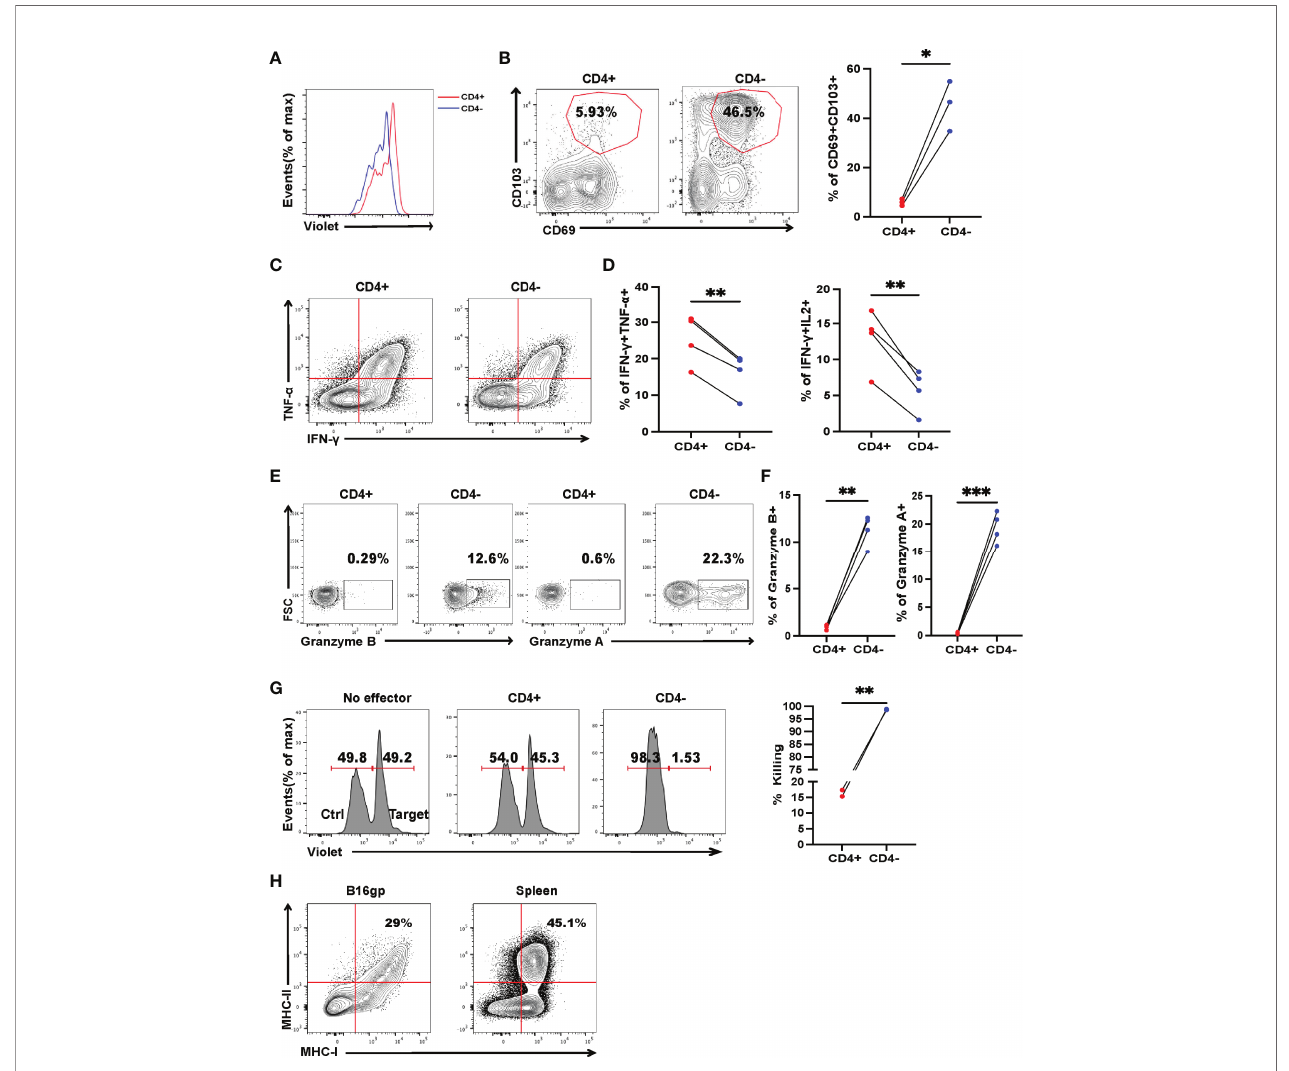
FIGURE 3 | Cytotoxic CD4 – T cells, differentiated from CD4 + T cells, are critical for controlling established tumor metastasis. Tumor-bearing mice were treated with 2 × 10 6 activated SMARTA cells eight days after tumor inoculation and sacri fi ced on Day 7 or Day 15 post-transfer. (A) Flow cytometry analysis of the dilution pattern of the cell proliferation dye on CD4 + and CD4 – SMARTA cells which were sorted from the metastatic lung tissue on Day 7 post cell transfer and labeled with CellTrace Violet, followed by in vitro stimulation of plate-bound anti-CD3(1ug/ml) and soluble anti-CD28(1ug/ml) for 72 h Cells are gated on live CD45.1 + cells. (B) Representative fl ow cytometry plots of CD69 and CD103 expression in CD4 + and CD4 – SMARTA cells on Day 15 post cell transfer. The frequencies of CD69 + CD103 + cells in each population are summarized beside. (n=3/group). (C, D) Representative FACS data of TNF- a and IFN- g production of CD4 + and CD4 – SMARTA cells after in vitro GP66-77 re-stimulation on Day 7 post-SMARTA transfer. Frequencies of IFN- g + TNF- a + and IFN- g + IL-2 + cells in the indicated populations are summarized in (D) . (n=4/group). (E, F) Representative FACS data of Granzyme A and Granzyme B production of CD4 + and CD4 – SMARTA cells after GP66 – 77 re-stimulation on Day 15 post cell transfer. Frequencies of Granzyme B + and Granzyme A + cells in the indicated populations are summarized in (F) . (n=4/group). (G) Flow cytometry analyzing the killing capacity of CD4 + and CD4 – SMARTA cells, in which Violet-high B220 + cells loaded with MHC class II-restricted peptide GP66 – 77 (recognized by SMARTA cells) were target cells, whereas Violet-low cells labeled with GP33 – 41 as control; the effector: target ratio is 10:1. The percentage of killing by the populations is summarized beside. (H) Flow cytometry plots of MHC-I and MHC-II expression in B16-GP cells harvested from metastatic lung or in splenocytes of C57BL/6J mouse (positive control). Statistical differences are calculated by paired student ’ s t test. * p < 0.05, ** p < 0.01, *** p <